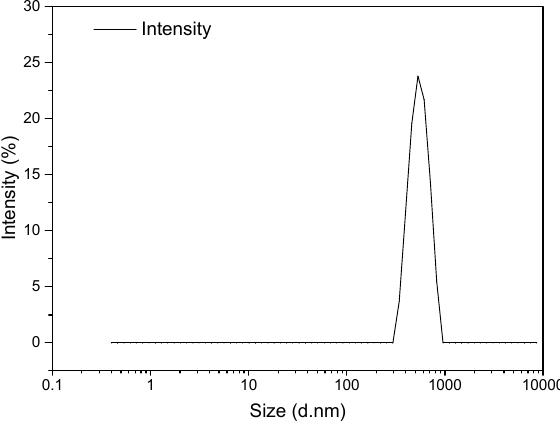
Figure 4. Dynamic light scattering (DLS) pattern of SiO 2 @IL microcapsules .